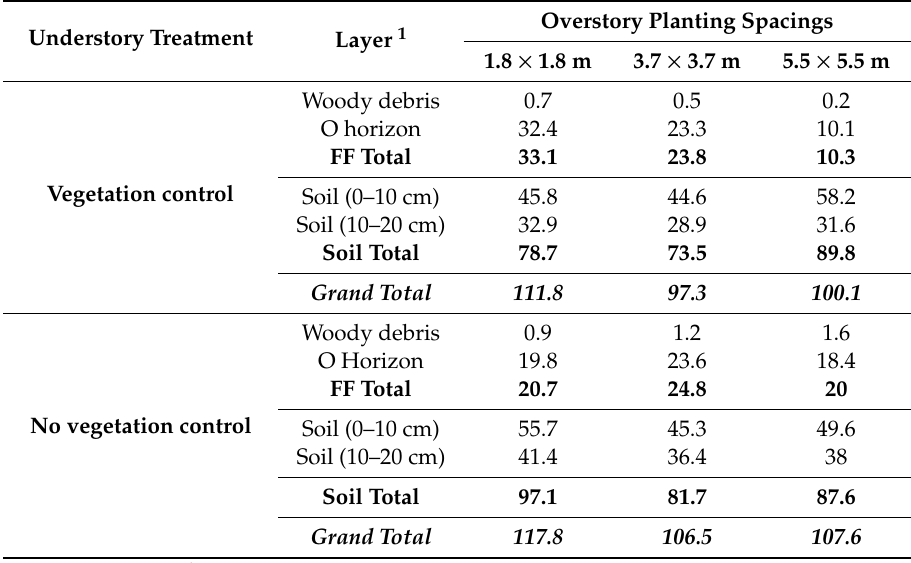
Table 3. Carbon pools (Mg C ha − 1 ) in forest floor and soil for 54-year-old plantation at Challenge Experimental Forest, California, USA. Treatments are three levels of planted spacings of pine and two vegetation controls of understory in a split plot